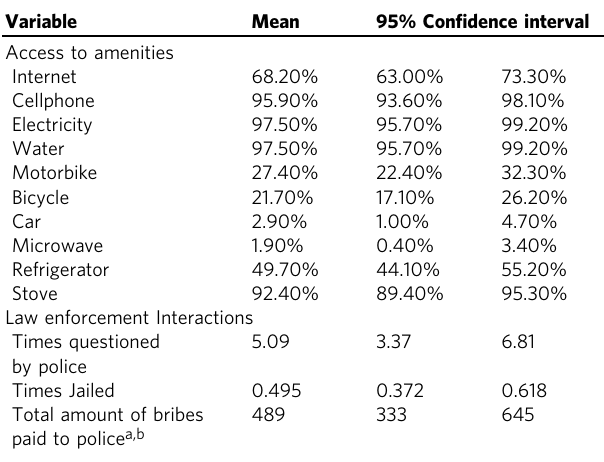
Table 3 provides two simple ordinary least-squares (OLS) regressions predicting the number of times jailed. The fi rst